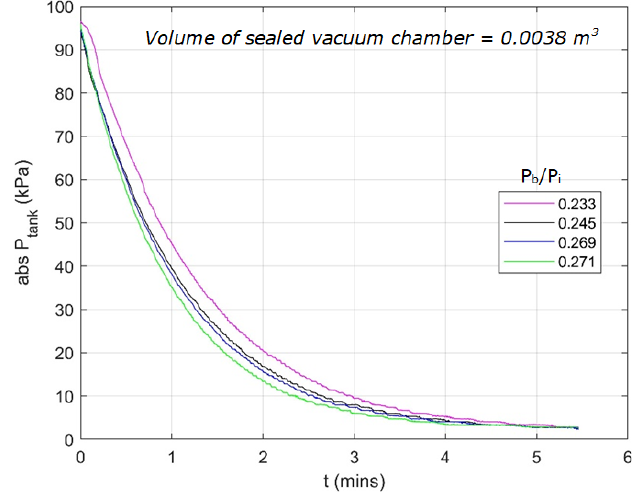
Figure 7. Degassing rate of eductor at different P b /P i for initialization of distillation desalination.